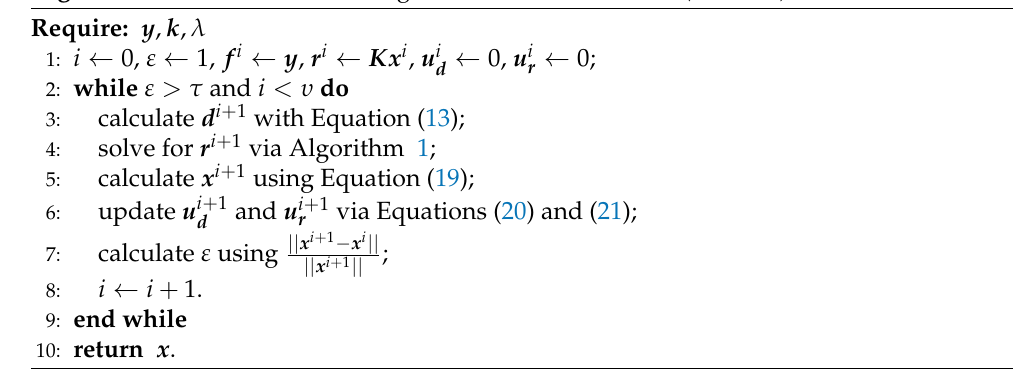
Algorithm 2 Nonlinear deblurring based on total variation